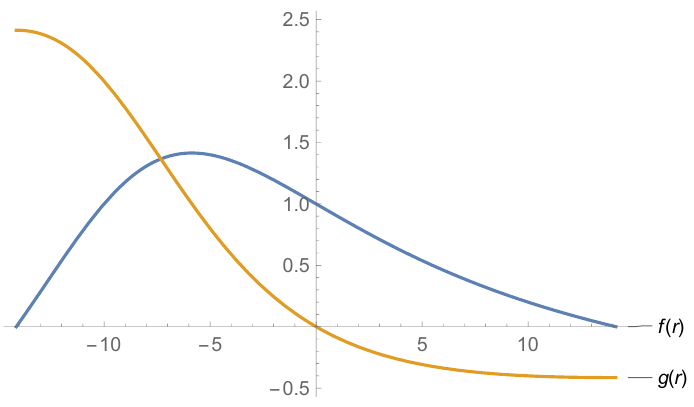
Figure 4 . Real (blue line) and imaginary part (orange line) of the scalar field with parameters G = 2 , c = 0 . 1 , r A = 1